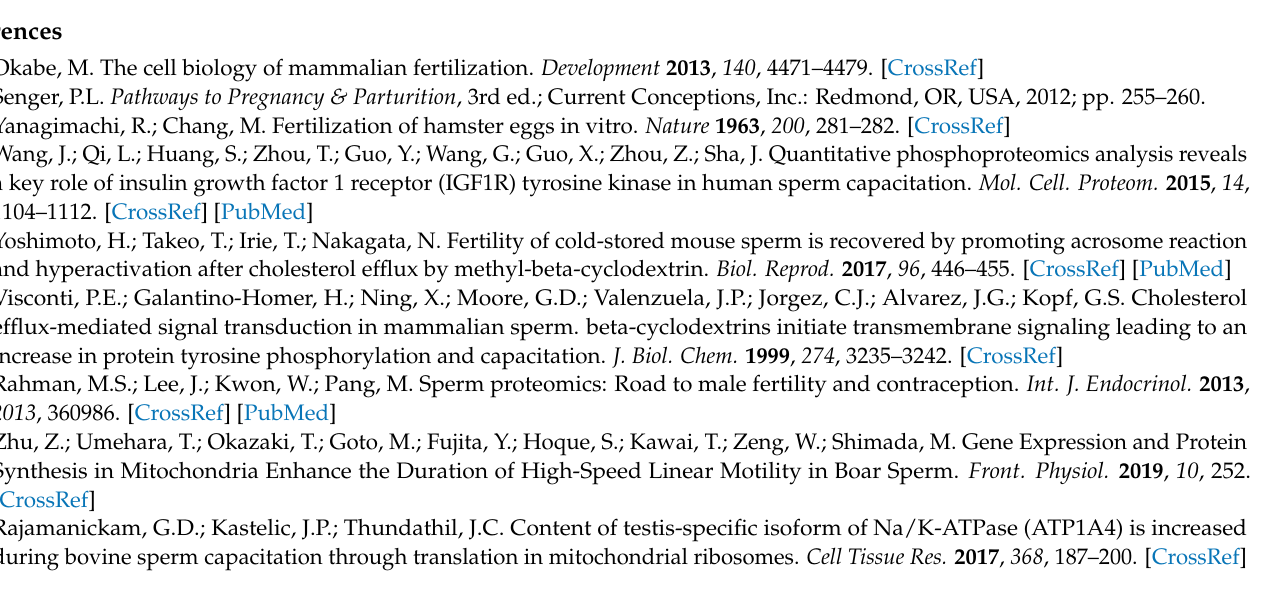
bovine sperm. Figure S2: Secondary antibody control and associated phase contrast field of tACE (a,b), β -tubulin (c,d), and ATP1A4 (e,f) in fresh (c–f) and 4 h capacitated (a,b) bovine sperm. Figure S3: Original unedited blots used in Figure 5 of the manuscript for (a) ATP1A4 and (b) β -tubulin. An additional blot (c) for β -tubulin immunoprecipitated using anti-tACE antibody exclusively after capacitation is also